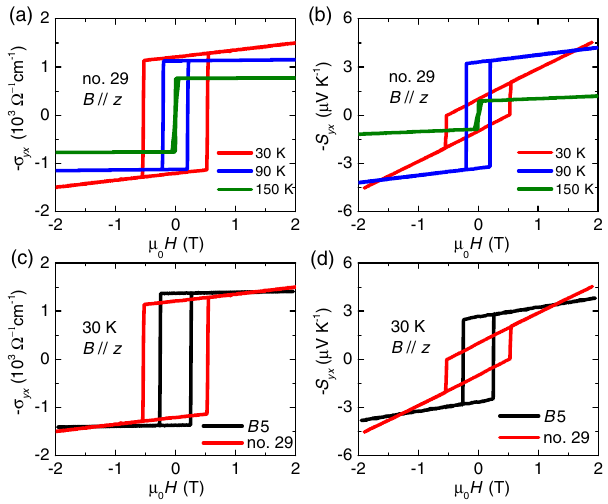
TABLE I. Electron (hole) Carrier density [ n ( p )] (in units of μ 10 19 cm − 3 ) together with their mobilities [ μ e ( h )] (in units of FIG. 3. Temperature-dependent AHE and ANE and their re- cm 2 V − 1 s − 1 ) in different samples. They were extracted using a sponse to disorder. Top: Temperature dependence. (a) The Hall two-band fit of the ordinary Hall conductivity. The average conductivity as a function of magnetic field at three different temperatures. (b) The Nernst coefficient as a function of magnetic field in at three different temperatures. Note the emergence of a hysteretic loopandanomalousresponsesinthe ferromagneticstate. Bottom: The effect of disorder. (c) The Hall conductivity compared in two samples (the clean no. 29 and the dirty B 5 ) at 30 K. (d) The Nernstcoefficientinthesame twosamplesatthesametemperature. The jump, which represents the anomalous component, is larger in the dirtier sample, but the slope, which represents the ordinary component, is larger in the clean sample. Note the wider hysteretic loop in the cleaner sample in both Hall and Nernst data.